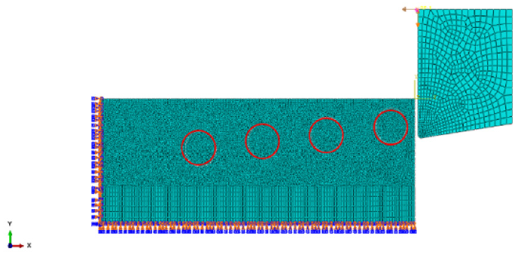
Figure 3. Cutting finite element model and load diagram. The left side and the bottom are fixed signs. The red circle represents the position of particles.